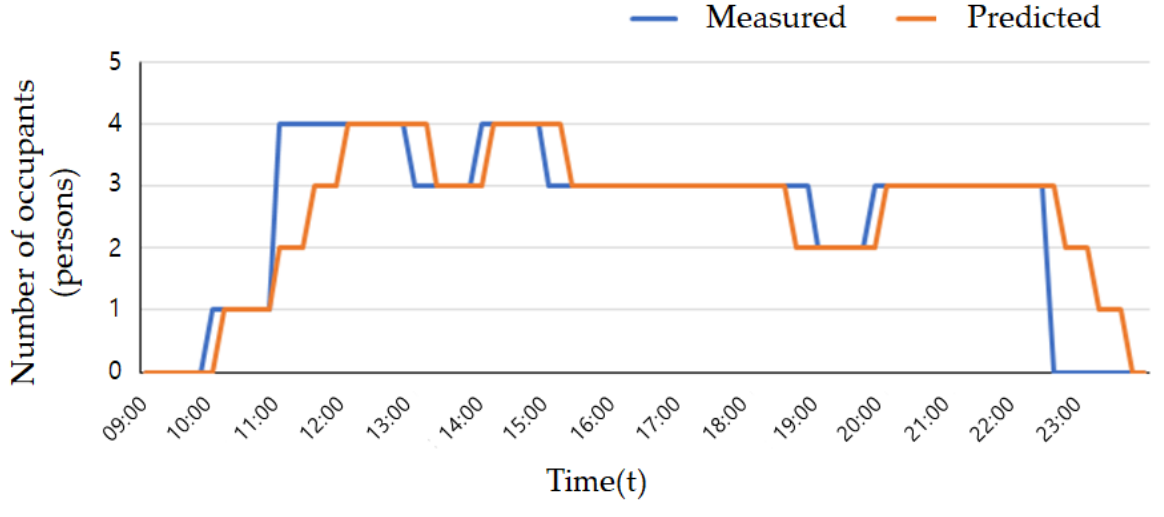
Figure 7. Comparison between the measured and predicted values for the number of occupants.